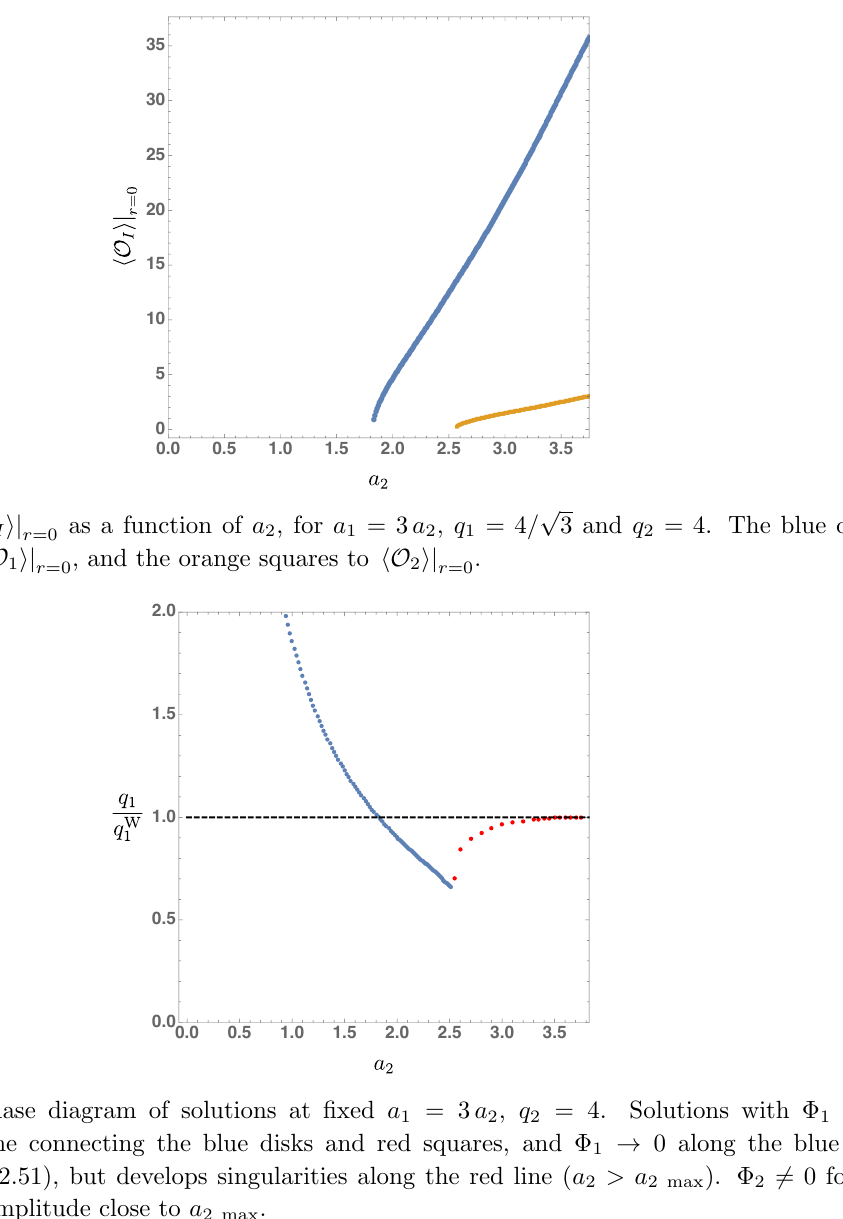
Figure 11 . Phase diagram of solutions at (cid:12)xed a 1 = 3 a 2 , q 2 = 4. Solutions with (cid:8) 1 6 = 0 exist above a line connecting the blue disks and red squares, and (cid:8) 1 ! 0 along the blue line ( a 2 < a 2 max (cid:25) 2 : 51), but develops singularities along the red line ( a 2 > a 2 max ). (cid:8) 2 6 = 0 for a 2 larger than an amplitude close to a 2 max